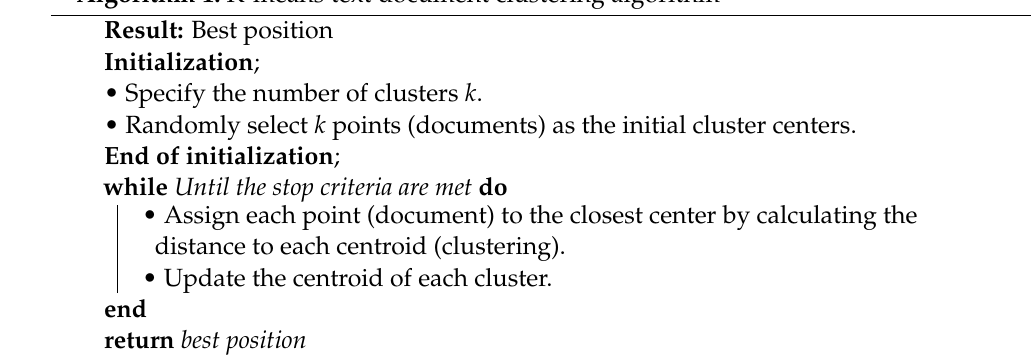
Algorithm 1: K-means text document clustering